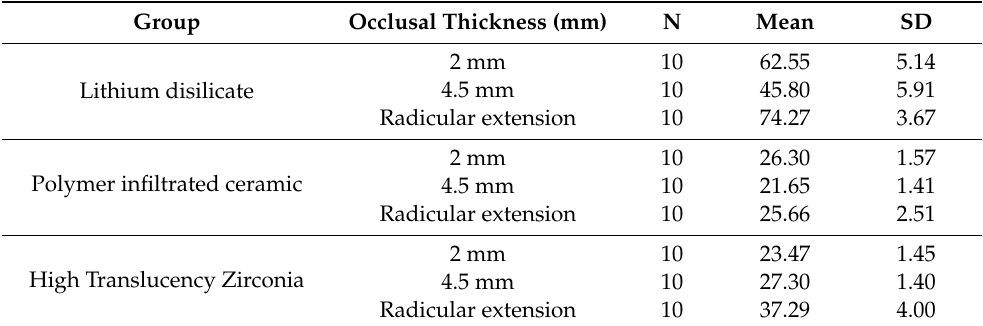
Table 1. Descriptive statistics of the mean fracture resistance at maximum load (MPa) recorded in the di ff erent